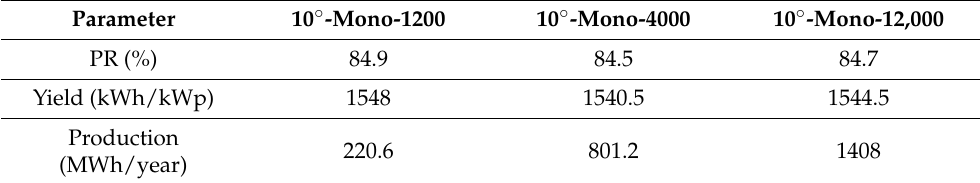
Table 4. Results of the simulation of the three base cases in the province of